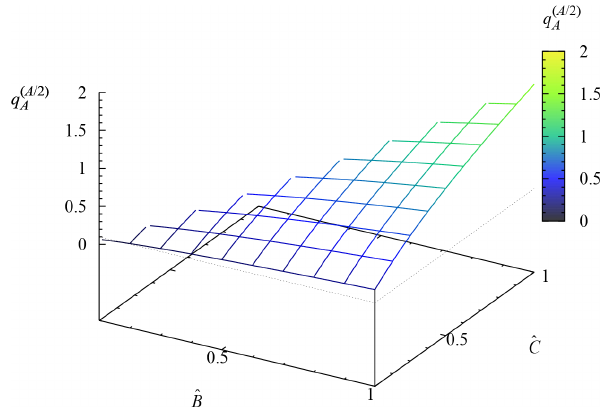
Figure A1. q (A/ 2 ) as a function of ˆ B and ˆ C for ˆ B, ˆ C ∈ [ 0 . 1 , 1 ] with A ˆ B > ˆ C . Dotted lines represent q (A/ 2 ) = 0 . A